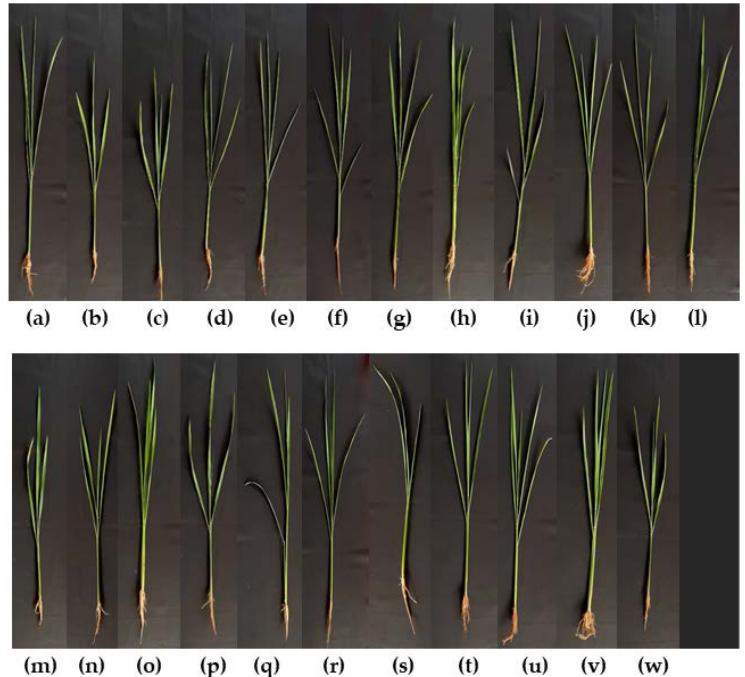
Figure 5. Rice seedlings (45-day-old) obtained from ( a ) seed treated with sterile water (negative control); ( b ) seed inoculated with C. lunata DOAC 2313 alone (positive control); and seed inoculated with C. lunata DOAC 2313 ( c ) with C. tropicalis YE-111; ( d ) with H. sinensis YE-19; (e ) with H. sinensis YE-58; ( f ) with H. sinensis DMKU-CP437; ( g ) with K. ohmeri DMKU-RP06; ( h ) with K. ohmeri DMKU-RP57; ( i ) with K.ohmeri DMKU-RP233; ( j )with M.caribica DMKU-RP07; ( k )with P.japonica YE-135; ( l )with R.mucilaginosa YE-171; ( m ) with R. taiwanensis YE-9; ( n ) with R. taiwanensis YE-213; ( o ) with T. indica DMKU-RP31; ( p ) with T. indica DMKU-RP35; ( q ) with W. anomalus DMKU-CP122; ( r ) with W. anomalus DMKU-CP127; ( s ) with W. anomalus DMKU-RP04; ( t ) with W. anomalus DMKU-RP25; ( u ) with W. anomalus YE-42; ( v ) with carbendazim ® ; or ( w ) with mancozeb ® .